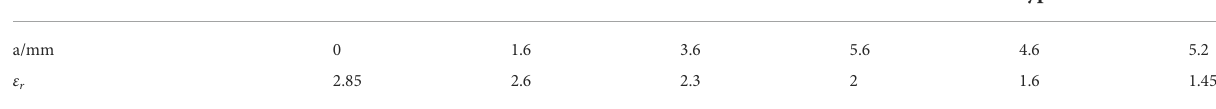
TABLE 2 Parameters of ring-type